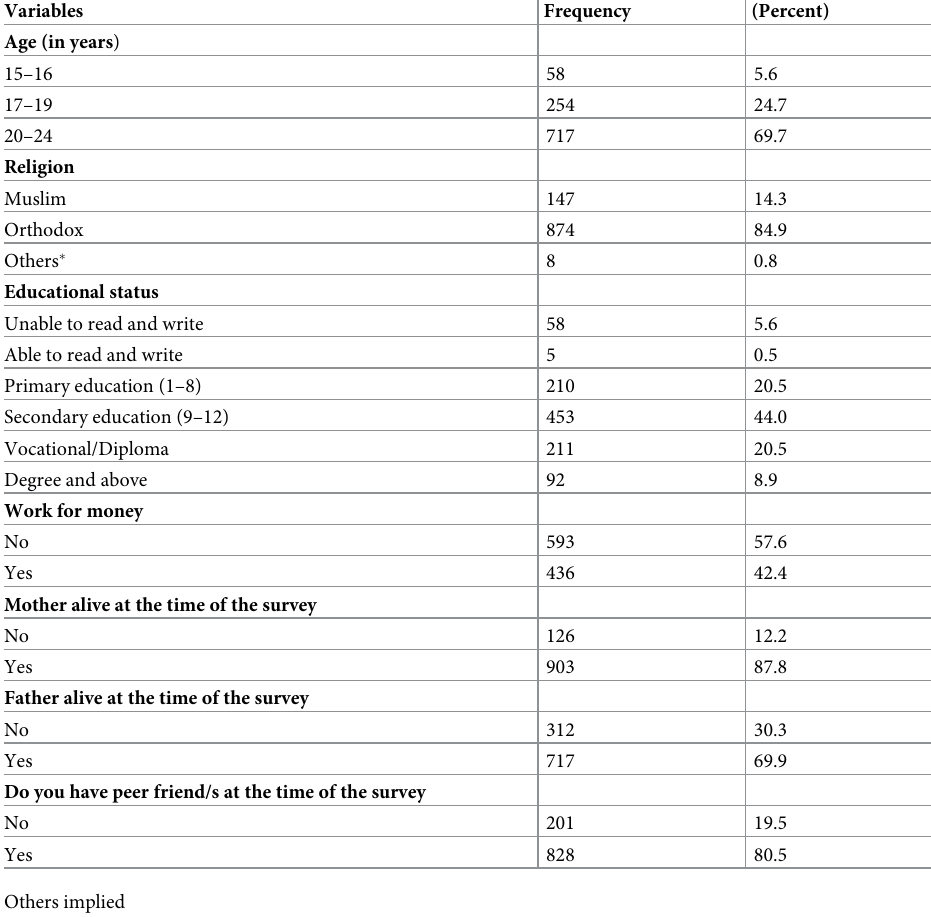
Table 1. Socio-demographic and other characteristics of youth Northwest Ethiopia in